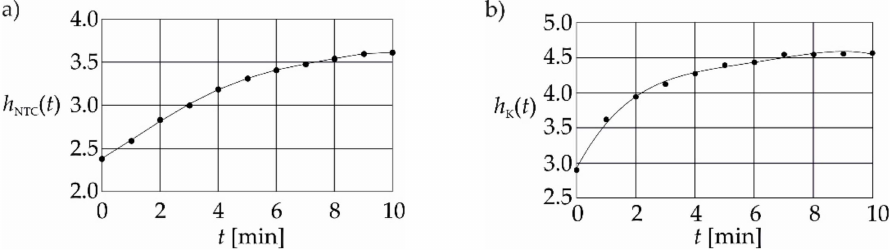
Figure 3. Step responses obtained for the negative temperature coefficient NTC ( a ) and K-type thermocouple ( b ) sensors.